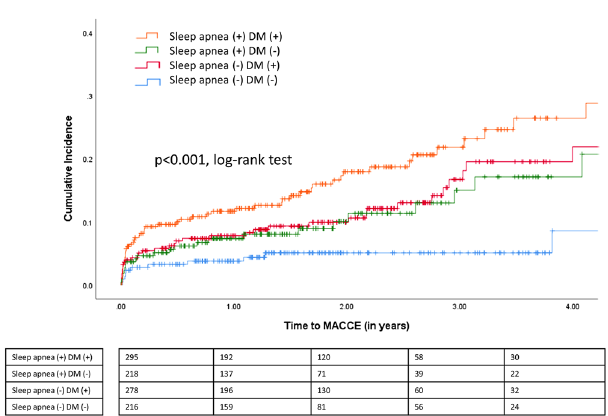
Figure 1. Cumulative incidence of major adverse cardiac and cerebrovascular events (MACCEs), defined as a four-component composite of cardiovascular mortality, nonfatal myocardial infarction, nonfatal stroke, and unplanned